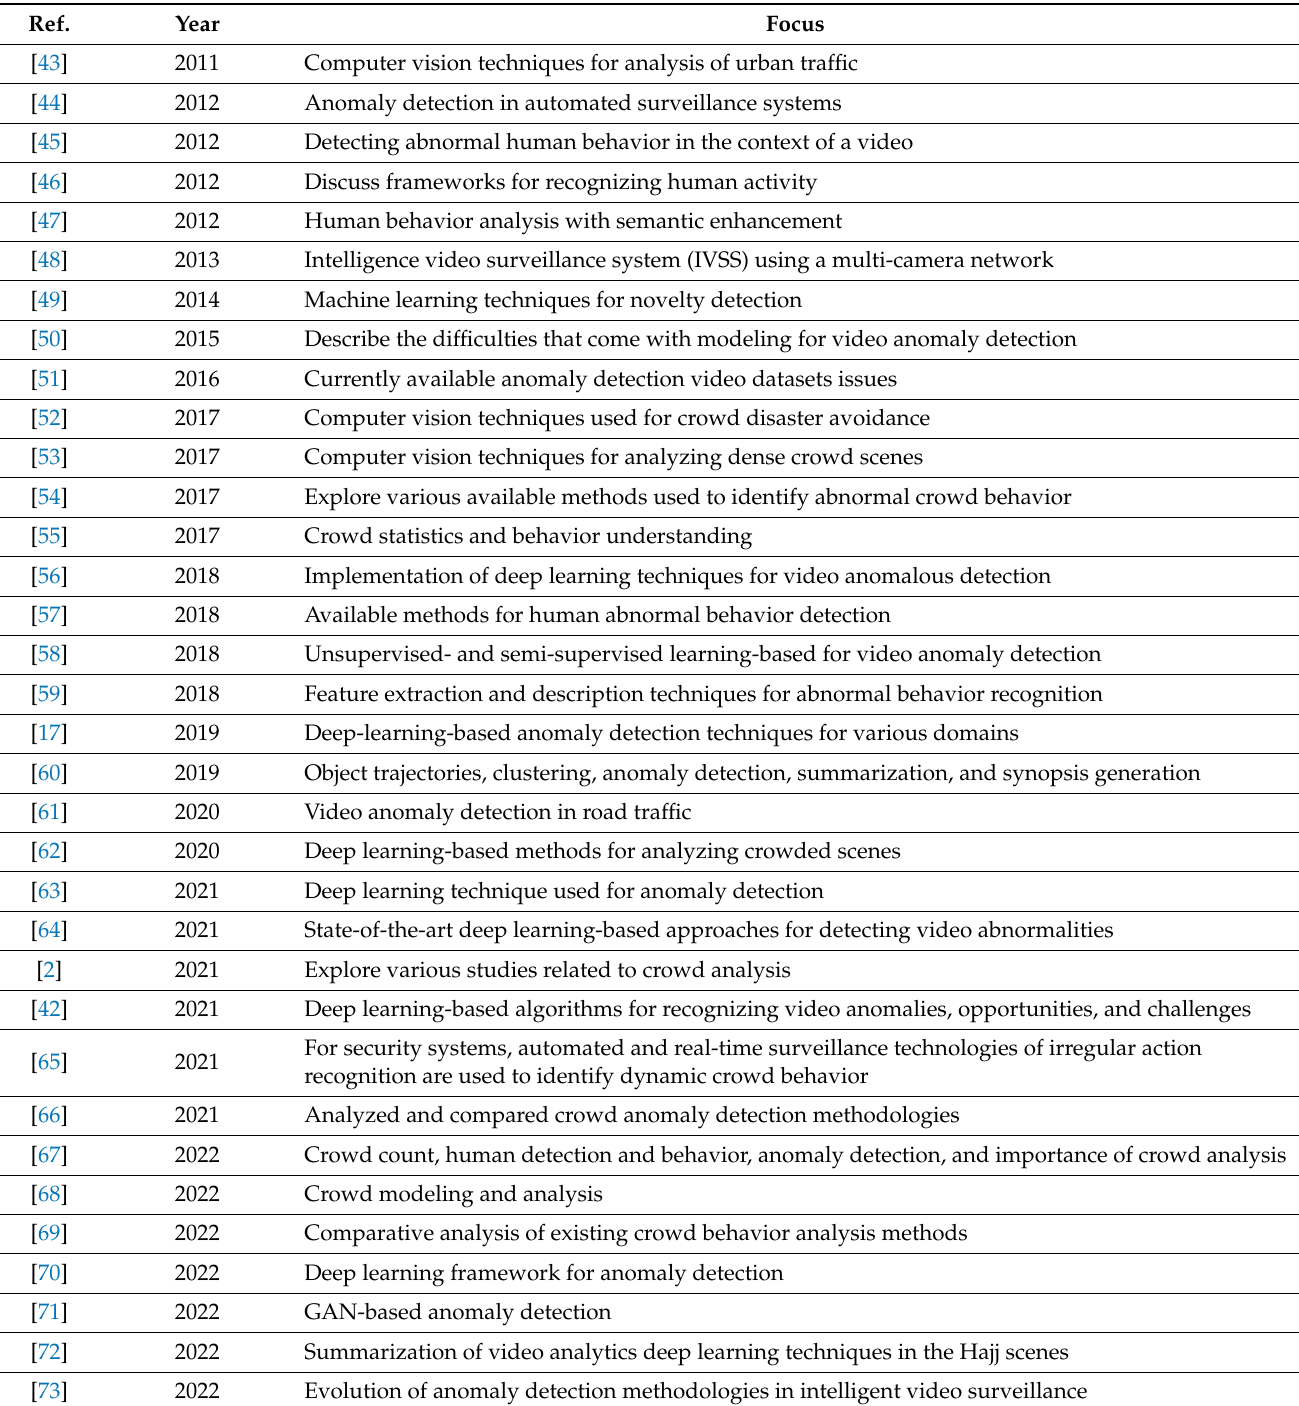
Table 1. Summarized presentation of review papers in anomaly detection.